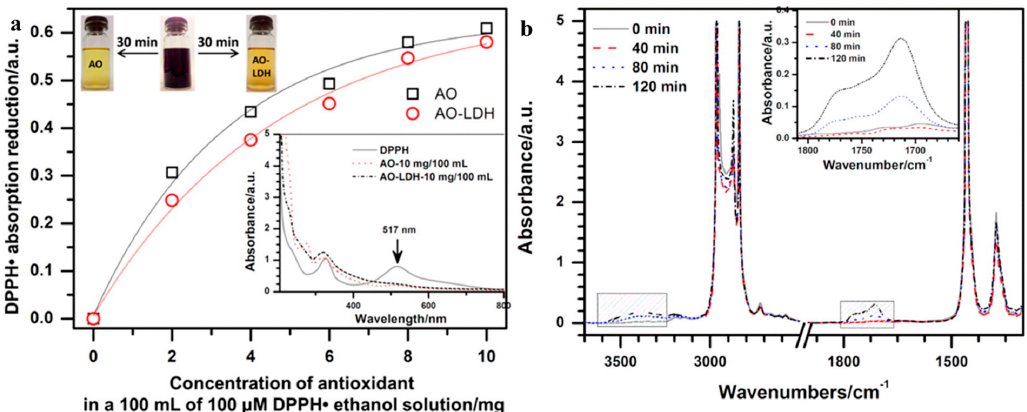
Figure 9. Radical-scavenging activity of BHPPA (denoted as AO) and BHPPA-LDH in a 100 mL of 100 µ M DPPH ethanolic solution. The top inset represents the color change and the bottom inset shows UV-Vis absorption curves after radical scavenging for 30 min in a dark box ( a ). FT-IR absorbance spectra of pure PP in the range of 3700–1250 cm − 1 as a function of accelerated thermal aging time at 150 °C. Inset shows a magnified region of the FT-IR spectra in the wavenumber range of 1810–1660 cm − 1 , thus the carbonyl region indicating oxidation of the plastic ( b ). Reprinted with permission from (Feng, Y.J.; Jiang, Y.; Huang, Q.; Chen, S.T.; Zhang, F.B.; Tang, P.G.; Li, D.Q. High